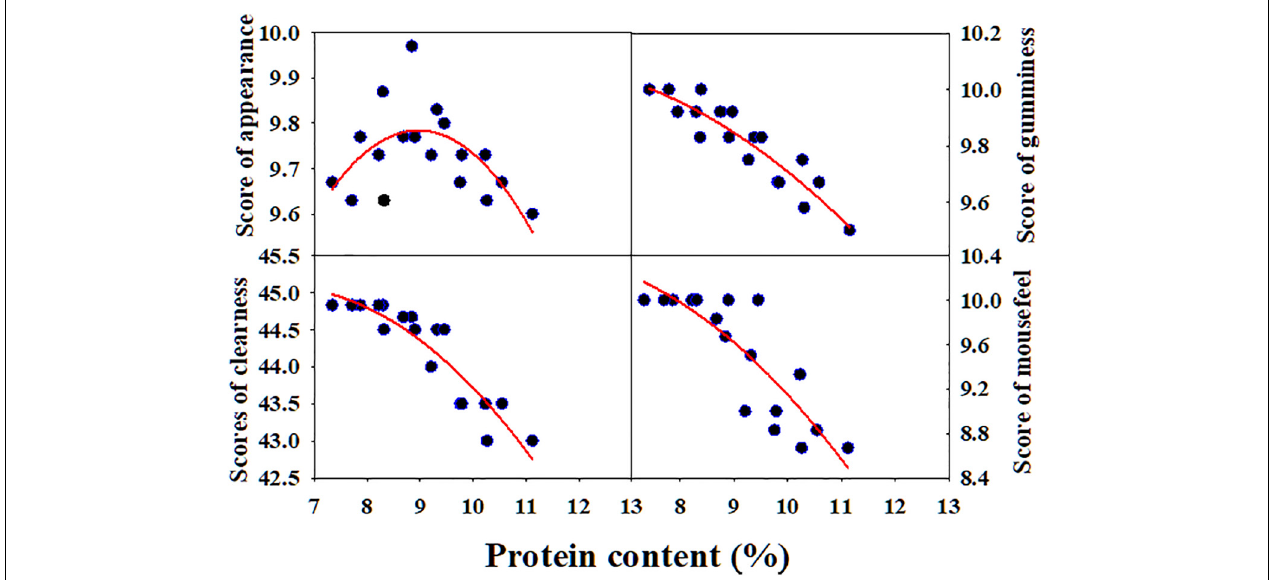
FIGURE 4 | Correlation of protein content with sensory scores of short biscuit. NM13, YM16, and ZM9023 indicate Ningmai 13, Yangmai 16, and Zhengmai 9023, respectively.